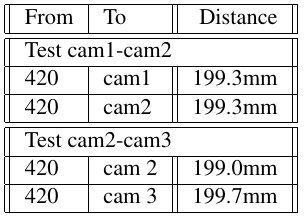
Table 10: Resulting distances of the offset calibration between two projection centers and the center of the mounted target (see sec. 3.5).